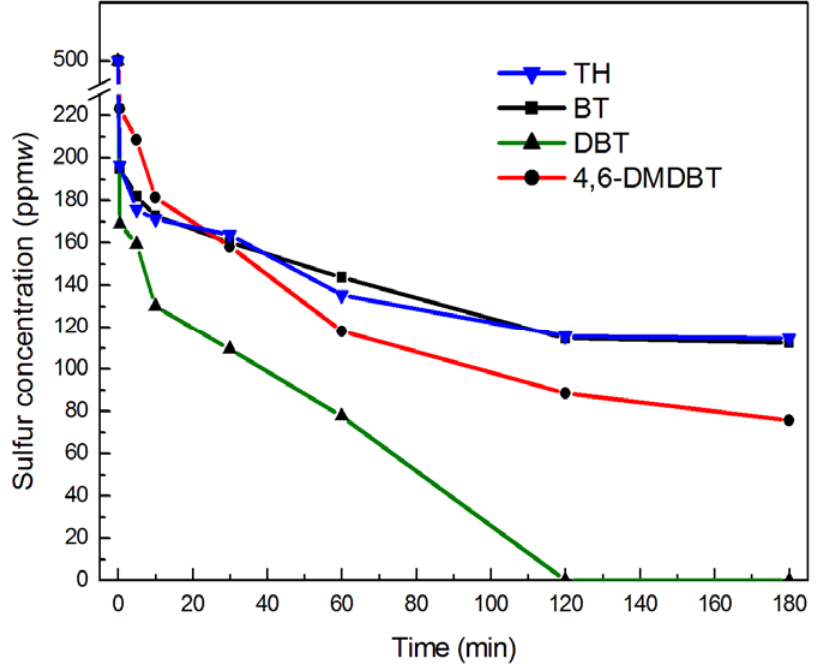
Figure 6. Catalyst effect of different sulfur compounds under the same conditions. Experimental condition: temperature 60 °C; O/S molar ratio 20; pre-reaction time 10 min; the amount of catalyst used was 1% the mass of n -octane; and different sulfur compound (S: 500 ppm( w )) in n